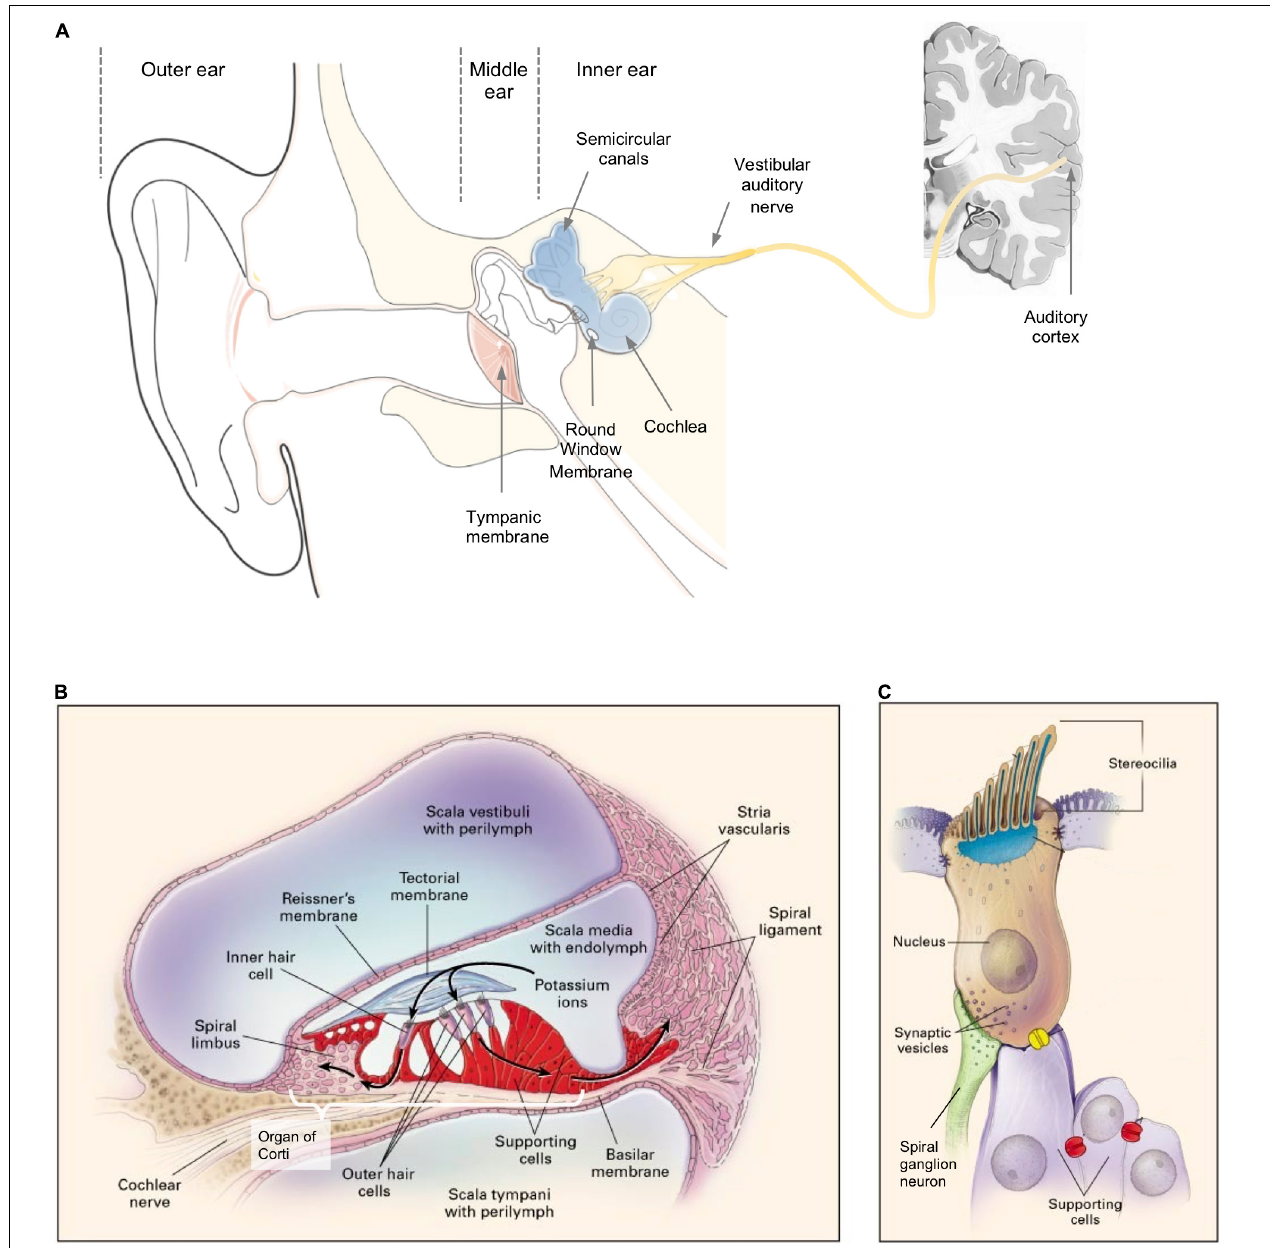
FIGURE 1 | (A) A schema of the structure of an ear; sensorineural hearing loss (SNHL) is caused by lesions to the inner ear or neurons along the vestibular auditory nerve from the cochlea to the brain. (B) A cross-sectional schema of the cochlea showing the three scalae and associated anatomical structures. (C) A schema of a sensory hair cell. (B,C) Reprinted from Willems and Epstein (2000) with